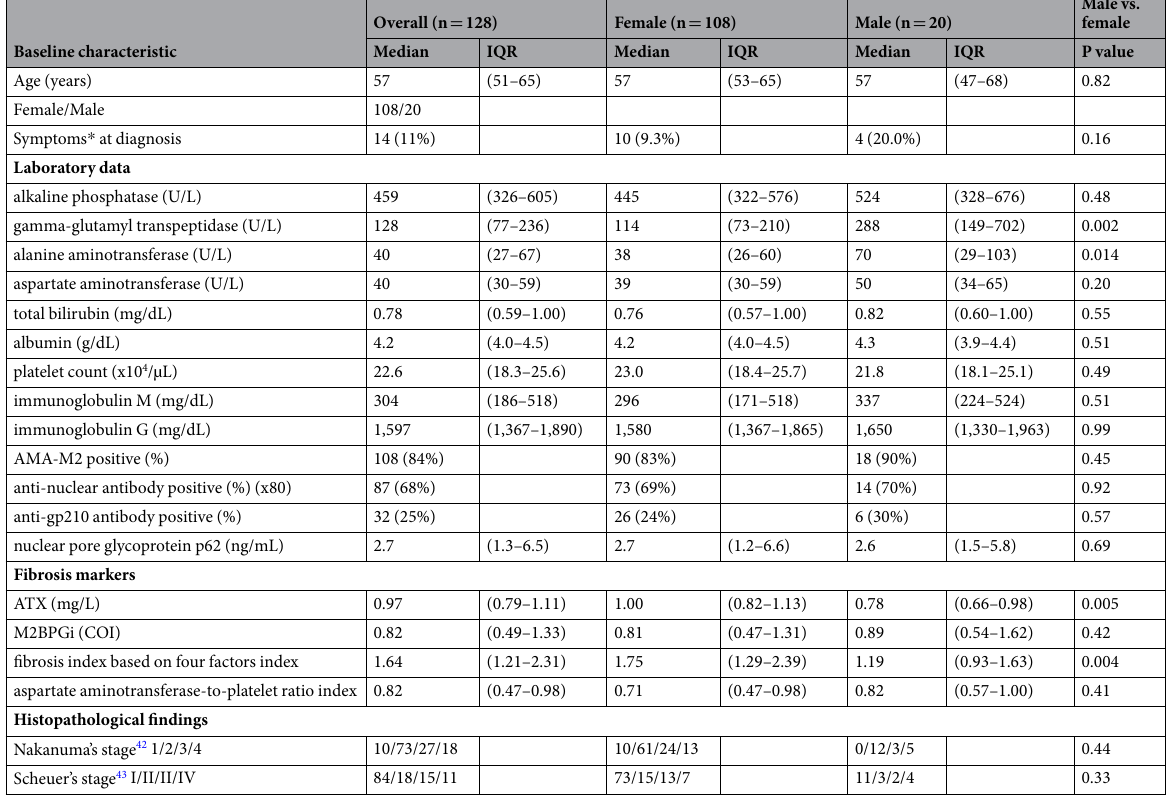
Table 1. Baseline clinical characteristics of 128 patients with primary biliary cholangitis. Data are expressed as the number (%) or median (first-third quartiles). * Symptoms include variceal bleeding, jaundice, fatigue, and pruritus. Abbreviations: IQR, interquartile range; AMA-M2, anti-mitochondrial antibody specific for the pyruvate dehydrogenase complex-E2 component; ATX, autotaxin; M2BPGi, Wisteria floribunda agglutinin- positive Mac-2 binding protein; COI, cutoff